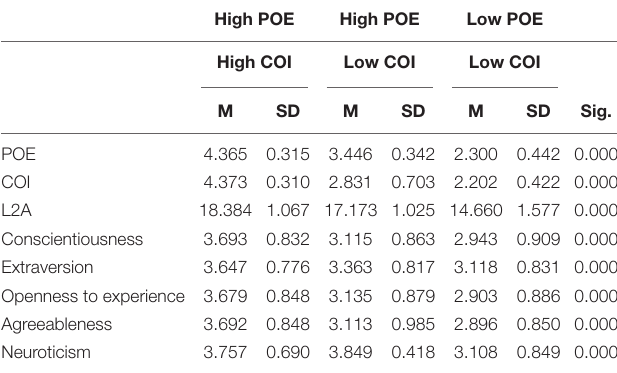
TABLE 3 | Grit cluster profile and their associations with big five personality factors.